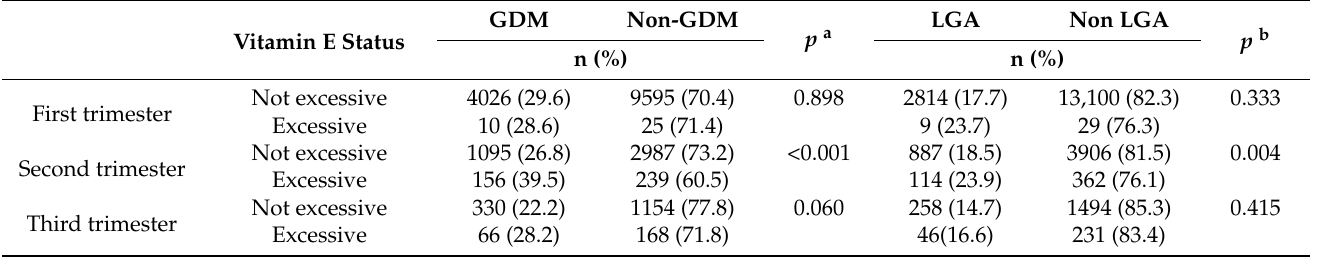
Table 3. The association between vitamin E status and GDM and large for gestational age (LGA), by univariate analyses.